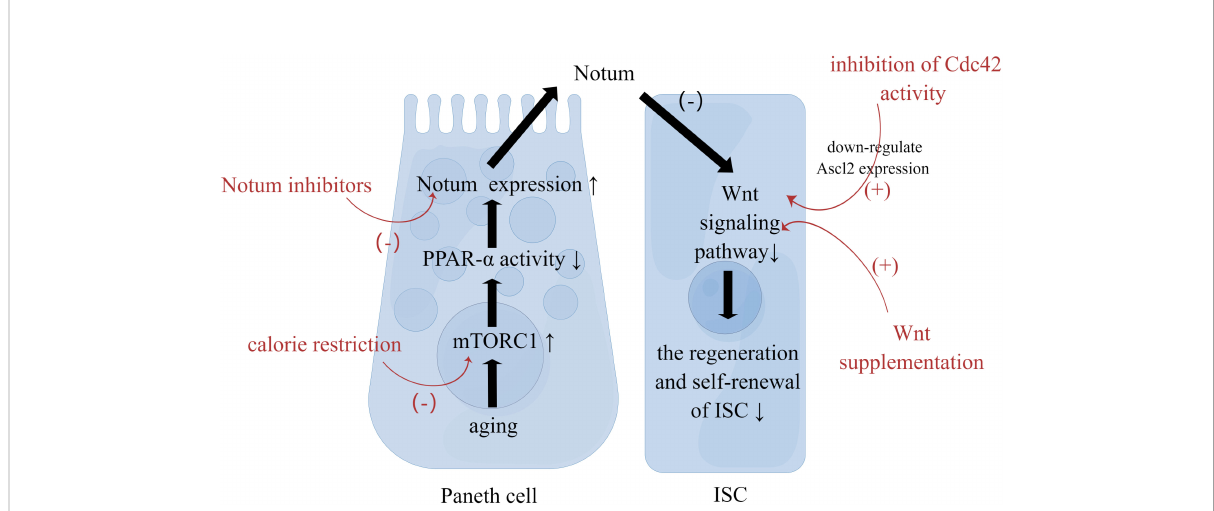
FIGURE 1 Strategies to Restore the Function of ISC. Paneth cells reside in proximity to ISCs. With aging, increased mTORC1 activity in Paneth cells alters the expression of Notum. Then Notum can diminish Wnt activity in ISC to impair function of aging IEC. Calorie restriction, Wnt supplementation, Notum inhibitors, and inhibition of Cdc42 activity can restore ISC function through the mechanism mentioned